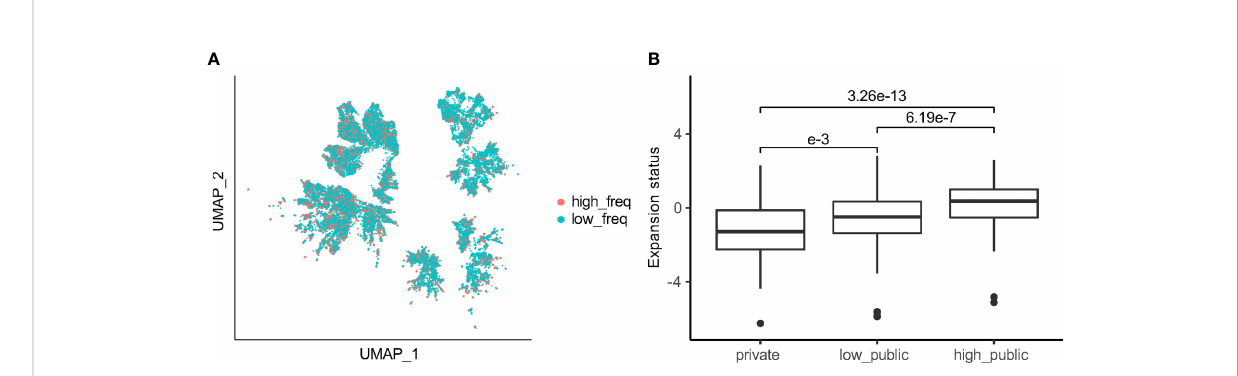
FIGURE 5 Public clones have a greater expansion status compared to private clones. (A) UMAP of V d 2 + TCR colored by high-freq/low-freq category. (B) Expansion status score for each publicity group. Games-Howell Post-Hoc Test was used to test the mean difference between groups. Adjusted P-values are shown between